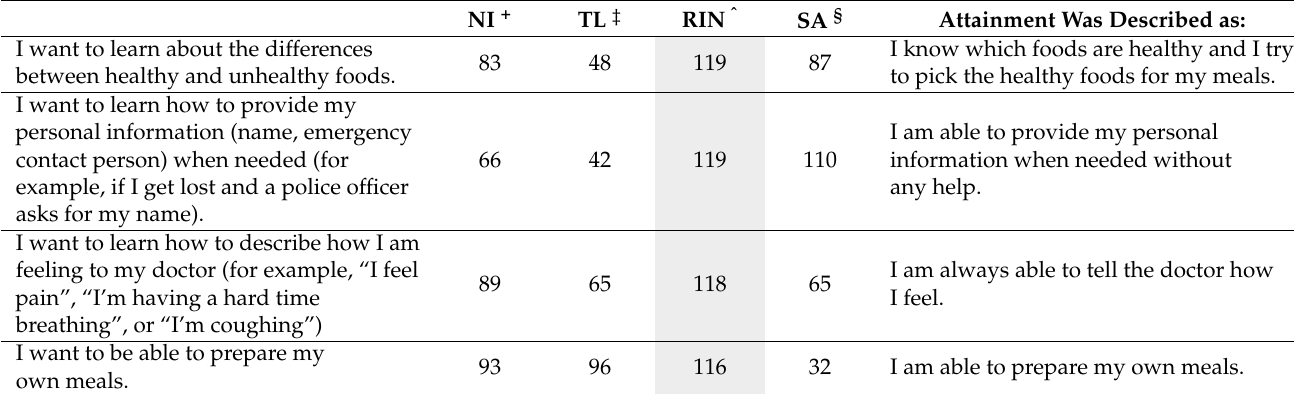
Table 3. Independence skills of 337 patients with Down syndrome age 13+ years in the MGH DSP. NI + TL ‡ RIN ˆ SA